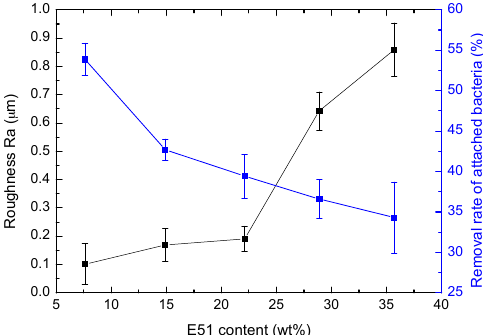
Figure 10. Roughness Ra and bacterial removal rate with E51 content.